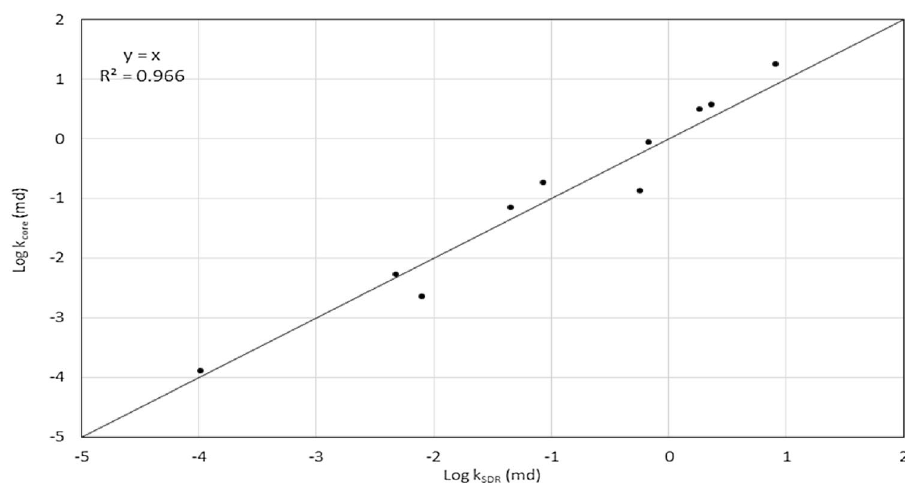
Fig. 15 Correlation of core permeability and permeability of modified SDR model (test model, m = 1.64, n =